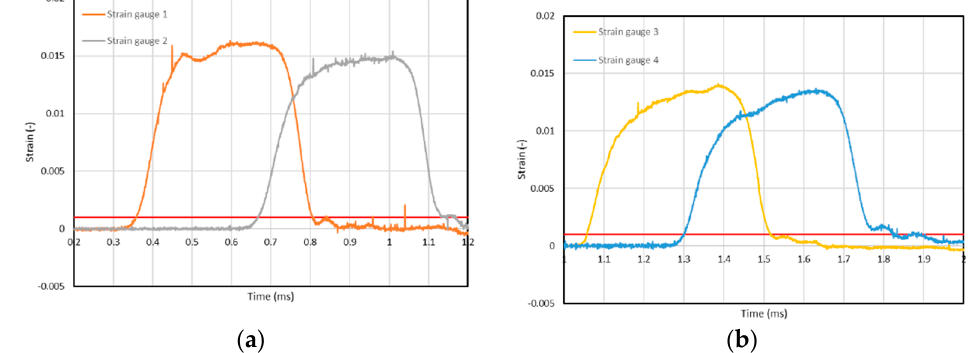
Figure 6. Values of strain vs. time recorded by strain gauges placed on the following bars: ( a ) incident; ( b ) transmission.